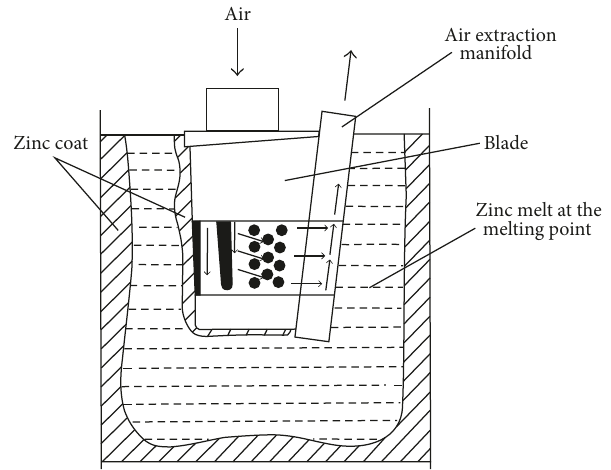
Figure 2: Method of calorimetric measurement in the molten metal